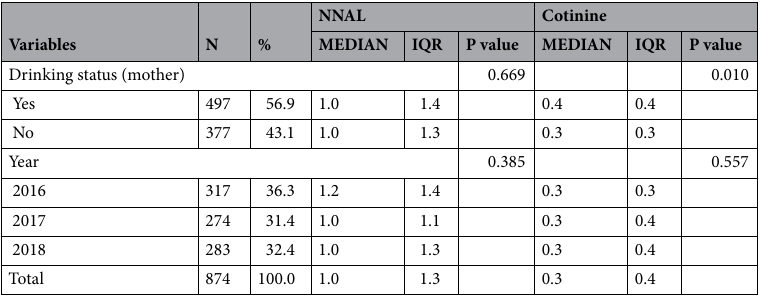
Table 1. General characteristics of the study population. BMI body mass index, IQR interquartile range, NNAL 4-(methylnitrosamino)-1-(3-pyridyl)-1-butanol, S.D. standard deviation, SHSE secondhand smoke exposure. *Age is a continuous variable and N = Mean, % = standard